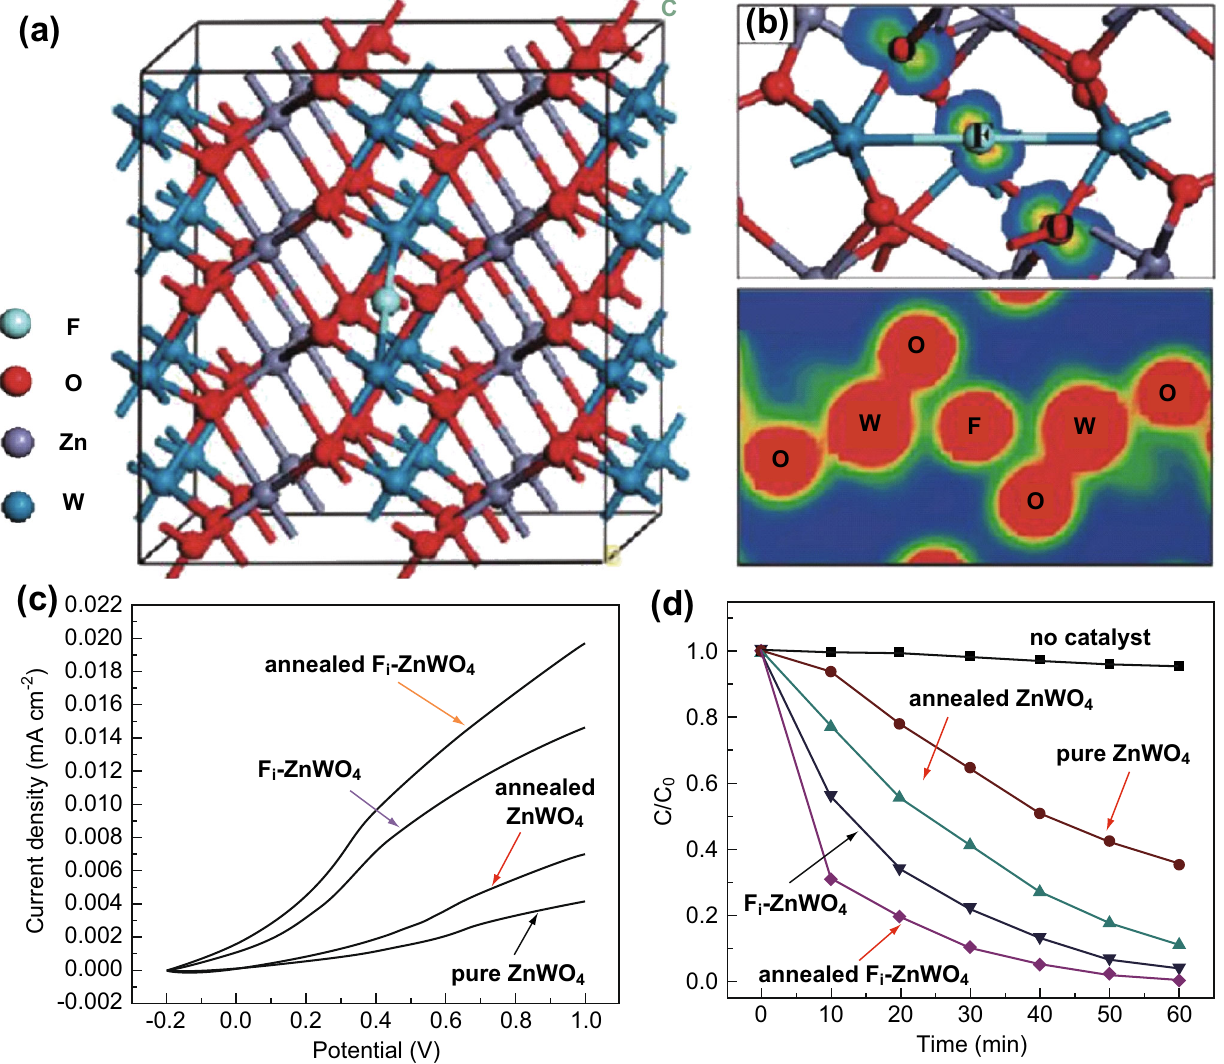
Fig. 13 a Geometric structures for the F i -ZnWO 4 . Spin density (top) and total charge density (bottom) for F i -ZnWO 4 . c Photocurrent density of the synthesized samples under UV-light irradiation. Photocatalytic degradation of RhB over different samples under UV light irradiation. Reprinted with permission from Ref. [140]. Copyright 2010 American Chemical